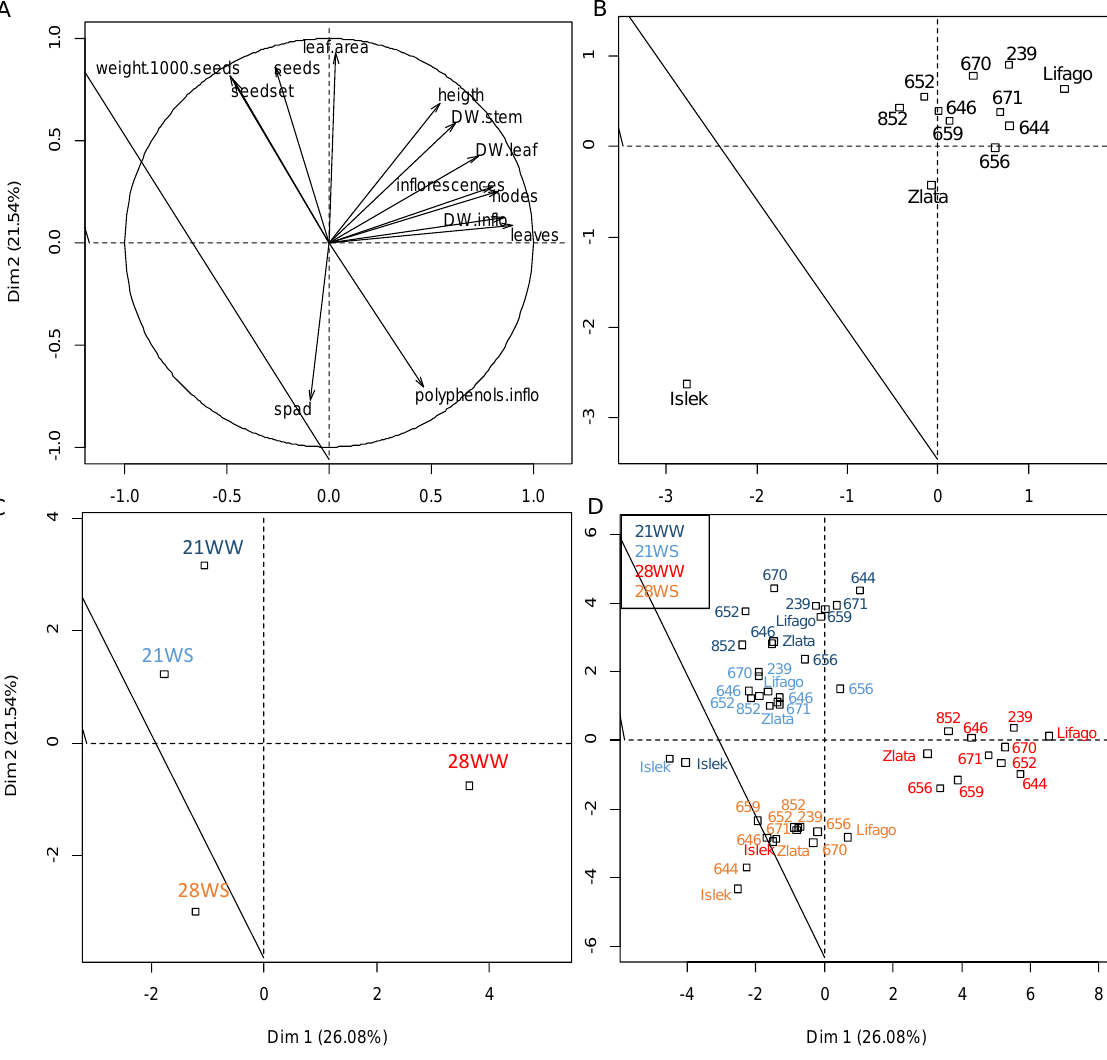
Figure 1. Principal component analysis (PCA) of plant growth and physiological parameters in F. tataricum varieties subjected to two temperatures (21 °C vs. 28 °C) and water supply conditions (well-watered vs. water-stressed). ( A ) Variable graph of PCA presenting growth and physiological parameters; only parameters with cos 2 > 0.5 are shown. ( B ) Individual graph presenting the average individuals according to the varieties of F. tataricum . ( C ) Individual graph presenting the average individuals according to the treatments: 21WW: 21 °C well-watered, 21WS: 21 °C water stress, 28WW: 28 °C well-watered, 28WS: 28 °C water stress. ( D ) Individual graph presenting the varieties according to the treatments. Dim 1 and Dim 2: dimensions 1 and 2 of the PCA; DW: dry weight; inflo: inflorescence; 659: PI481659; 656: PI481656; 652: PI481652; 239: PI427239; 852: PI476852; 646: PI481646; 670: PI481670.